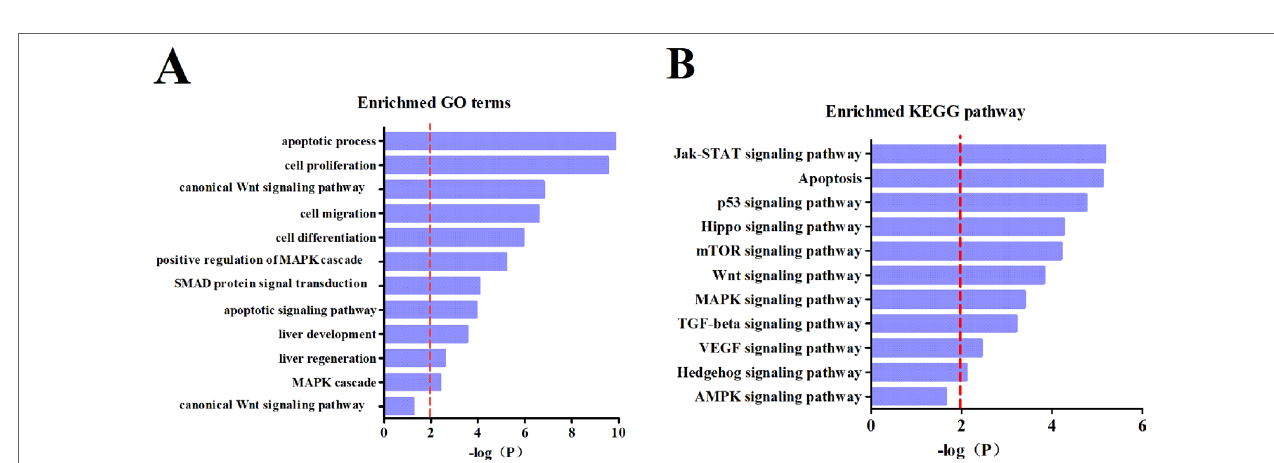
FIGURE 4 | qRT-PCR validations of intestinal microRNA expression within HCC mice, n = 5, *P < 0.05.